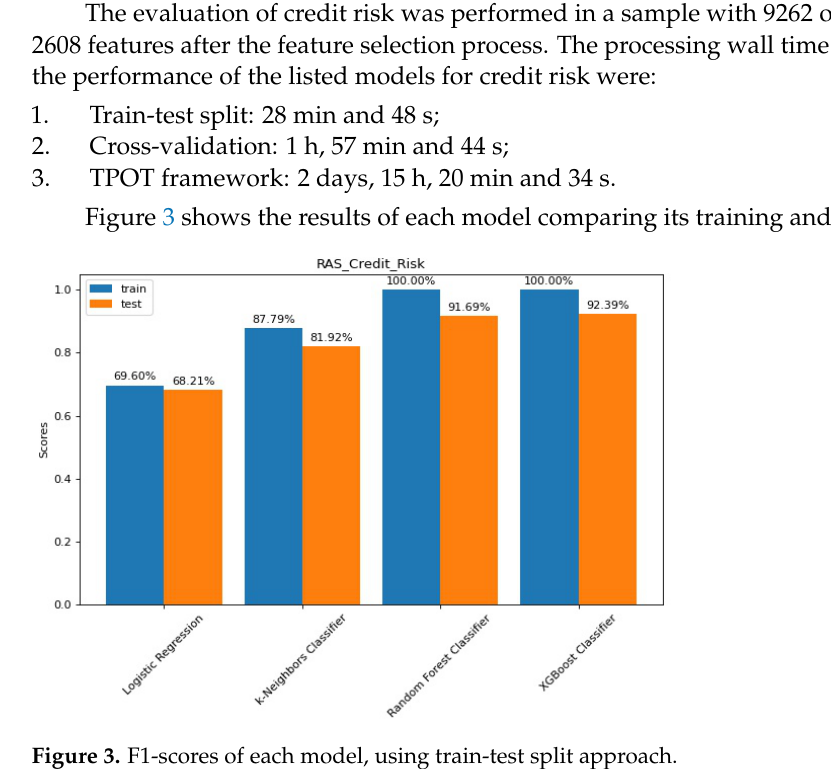
Figure 3. F1-scores of each model, using train-test split